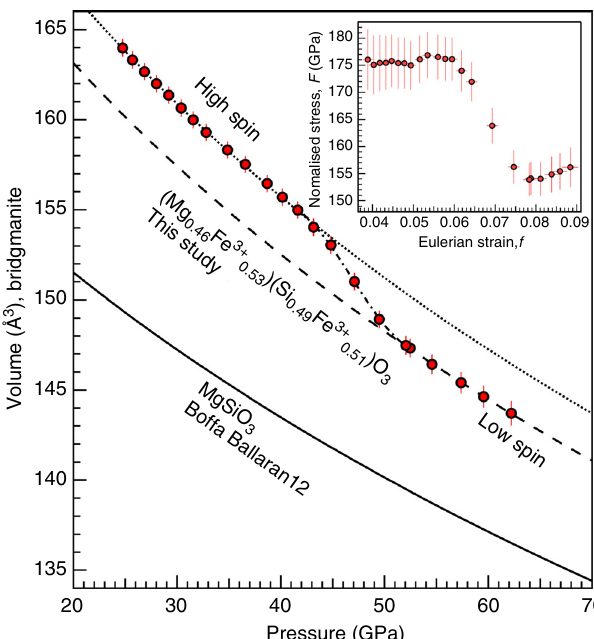
Fig. 2 Compression behavior of bridgmanite (Bdg) at 300 K across the spin transition. An unit cell volume of (Mg 0.46 Fe 3 + 0.53 )(Si 0.49 Fe 3 + 0.51 )O 3 Bdg and second order Birch – Murnaghan equation of state fi ts to the high-spin data between 24.7 and 43.1 GPa (dotted) and 50% low-spin data between 52.5 and 61.4 GPa (dashed). Softening is observed between 43.1 and 52.5 GPa (dot dashed). The compression curve of MgSiO 3 Bdg is also plotted for comparison (black curve 38 ). Inset: normalized stress F vs. Eulerian strain f calculated using the fi tted 1-bar unit cell volume from the lower pressure segment, revealing a discontinuity between 43.1 and 52.5GPa. The error bars are 95% con fi dence